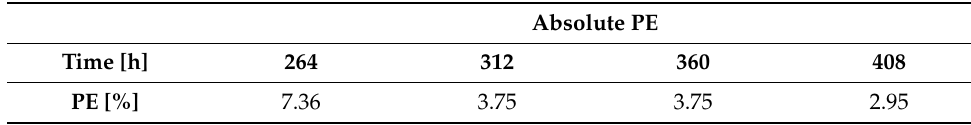
Table 10. Absolute PEs on average AUC[0-t] at 375 mg dose level.